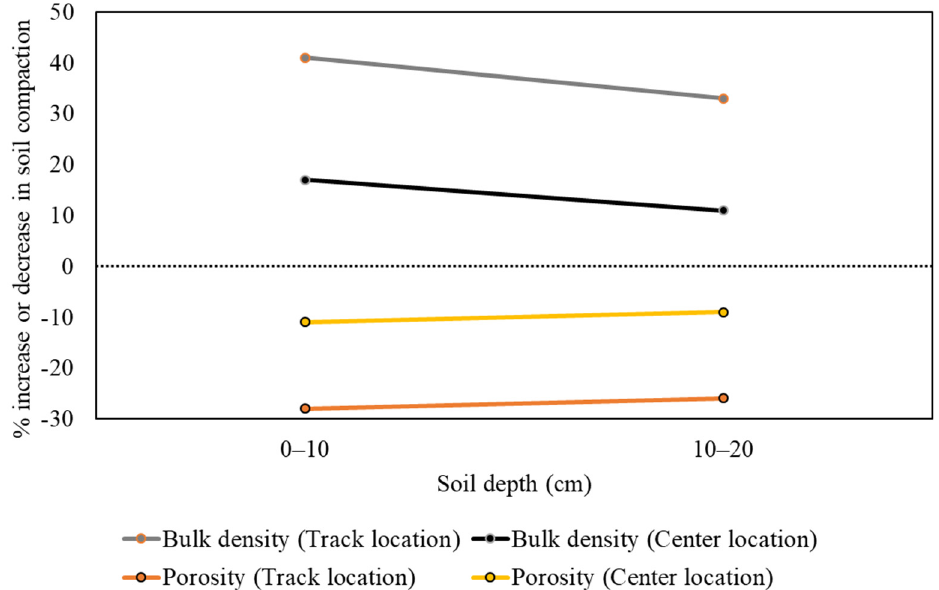
Figure 5. Percentage increase in bulk density and decrease in porosity on the track and center locations after forwarder passing at 0–10 cm and 10–20 cm soil depths.